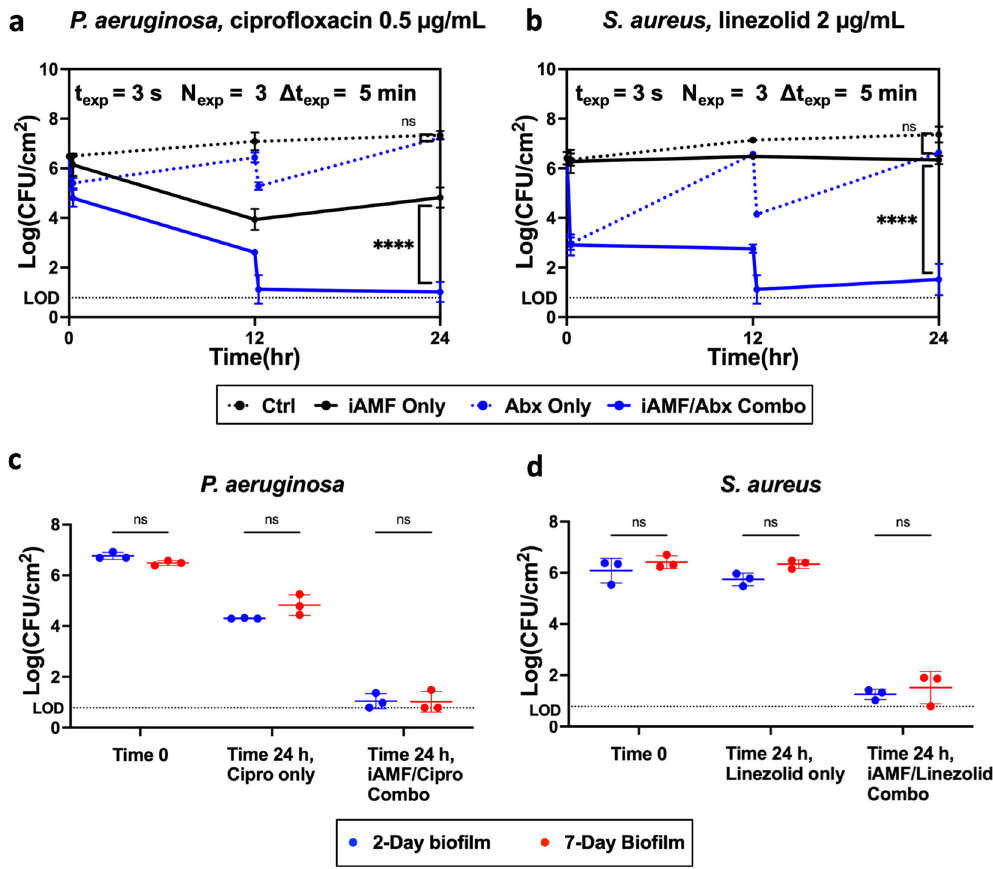
Fig. 6 iAMF and antibiotics can work on bio fi lm of various ages. P. aeruginosa (PAO1) and S. aureus (UAMS1) bio fi lms were cultured until day 7 following the same protocol with media replenishment every 24 h. Then the bio fi lms were treated with iAMF doses at 0 and 12 h ( T max = 65 °C, Δ t exp = 5 min, 15 min per dose) and speci fi ed antibiotics. a 7-day P. aeruginosa (PAO1) bio fi lm log reduction (CFU) post 24 h with iAMF and 0.5 μ g mL − 1 cipro fl oxacin. CFU was counted at time points 0, 12 (pre- and post-AMF), and 24 h. b 7-day S. aureus (UAMS1) bio fi lm log reduction (CFU) post 24 h with iAMF and 2 μ g mL − 1 linezolid. CFU was counted at time points 0, 12, and 24 h. c Comparison of prior 2-day (48 h) bio fi lm and 7-day P. aeruginosa (PAO1) bio fi lm under the same iAMF ( T max = 65 °C, Δ t exp = 5 min, 15 min per dose) treatment and 0.5 μ g mL − 1 cipro fl oxacin at time 0 and 24 h. d Comparison of 2-day (48 h) bio fi lm and 7-day S. aureus (UAMS1) bio fi lm under the same iAMF ( T max = 65 °C, Δ